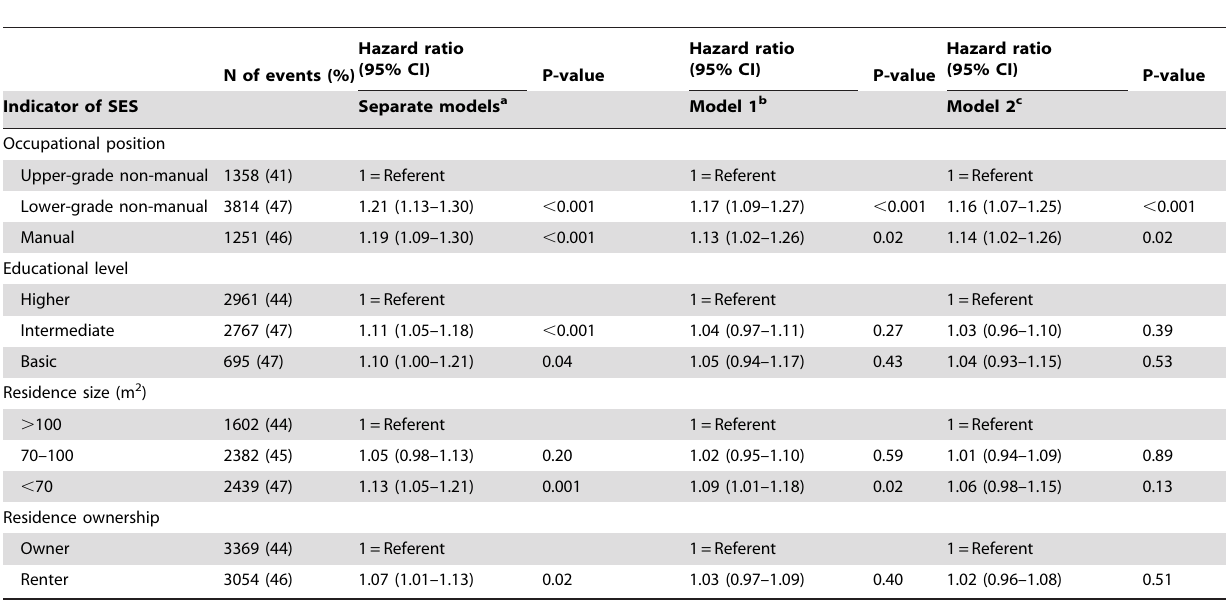
Table 4. Associations between indicators of socioeconomic status and recurrence of work disability due to depression.